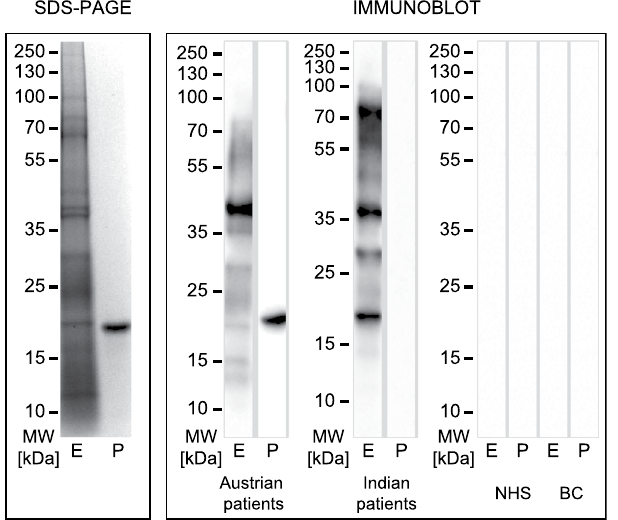
Figure 3. Immunoblot analysis of feverfew pollen extract (E) and purified recombinant Par h 1 (P). Extract and Par h 1 were loaded on reducing SDS-PAGE and stained with Coomassie. Immunoblot analysis was performed with a serum pool of Austrian weed pollen allergic patients (n = 15) and Indian feverfew pollen sensitized patients (n = 25). The unprocessed gels and immunoblots are shown in the Related Manuscript File. NHS, non- atopic human sera (n = 2) and BC, buffer control.